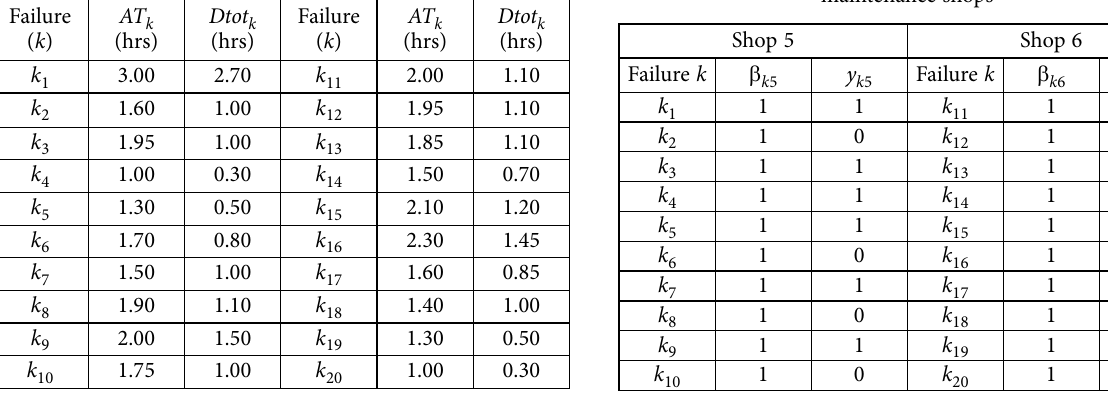
Table 5. Sequence of emergent failure repairs in the idle maintenance shops